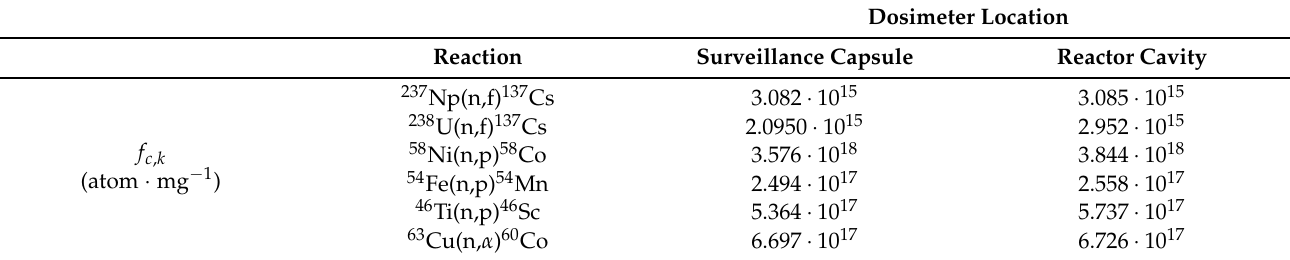
Table 4. Reaction rates for a specific activity conversion factor, taken from